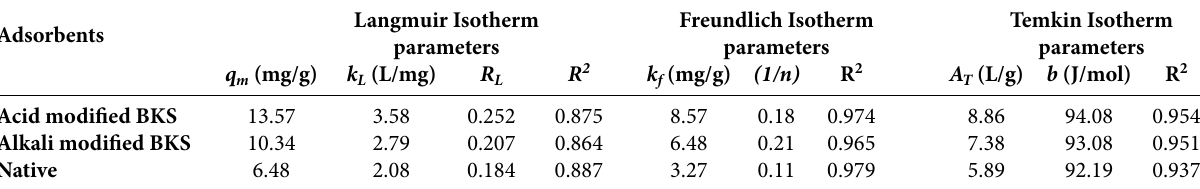
Table 6. Isotherm Parameters for As(III) ions adsorption using native and chemically modified slag